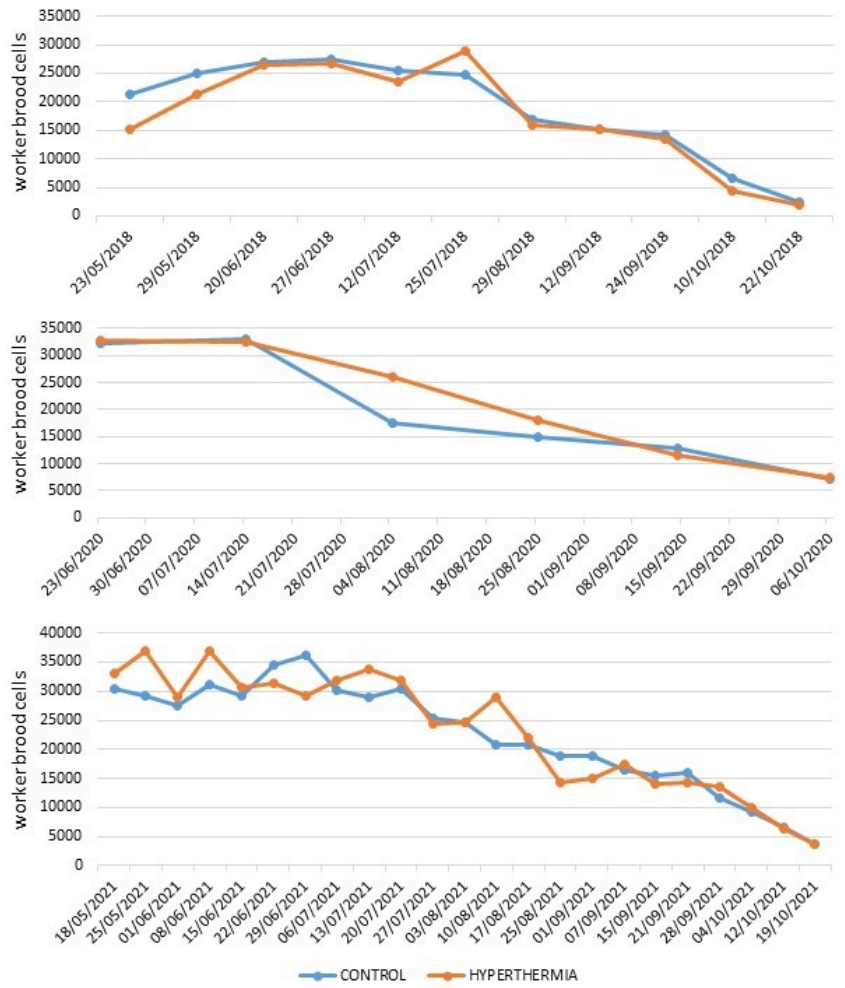
Figure 3. Average number of worker brood cells in the beehives used in 2018 (above), 2020 (middle), and 2021 (below) tests.